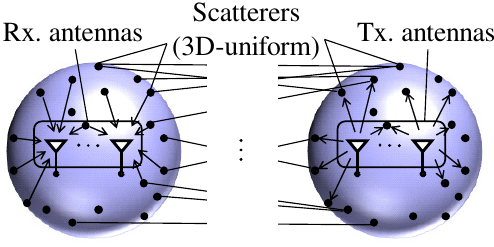
Figure 8. Conceptual sketch of GSCM.